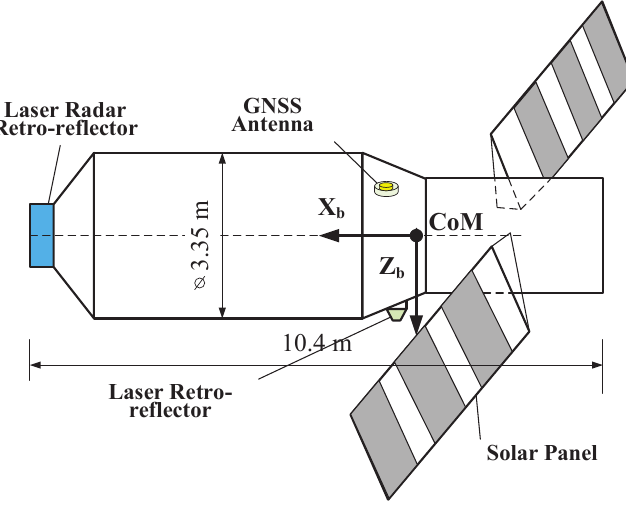
Figure 11. The satellite-body-fixed XYZ coordinates on